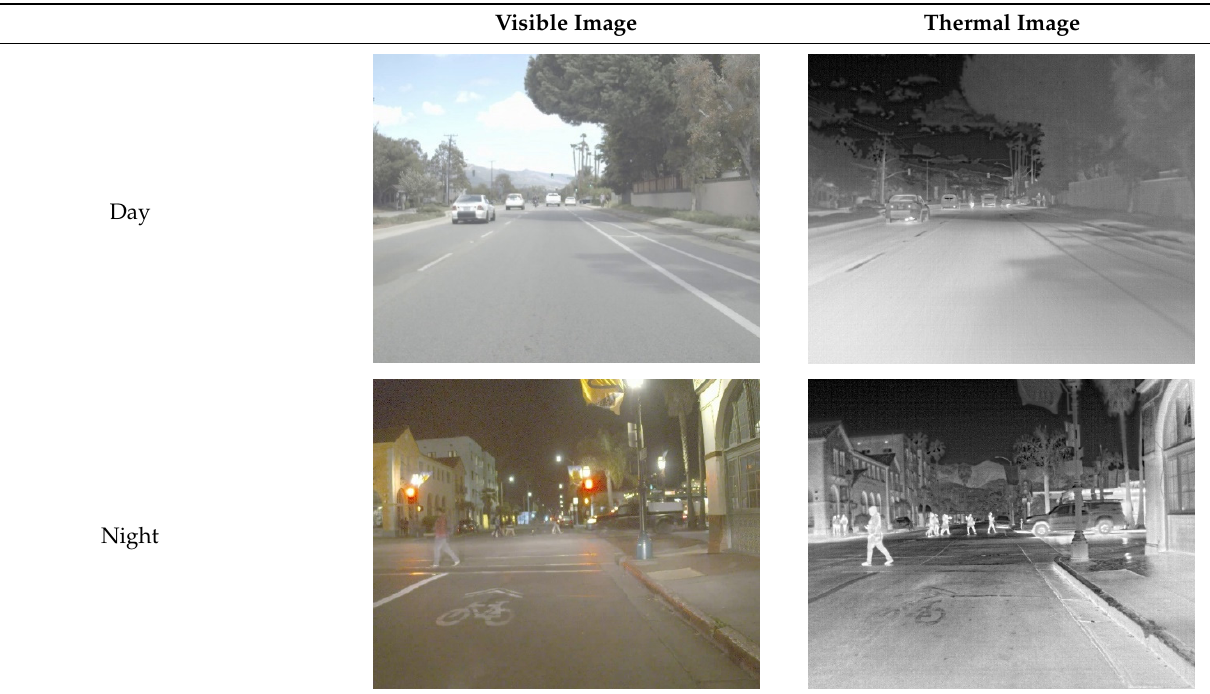
Table 1. Examples of different illumination scenes in the FLIR dataset [14].